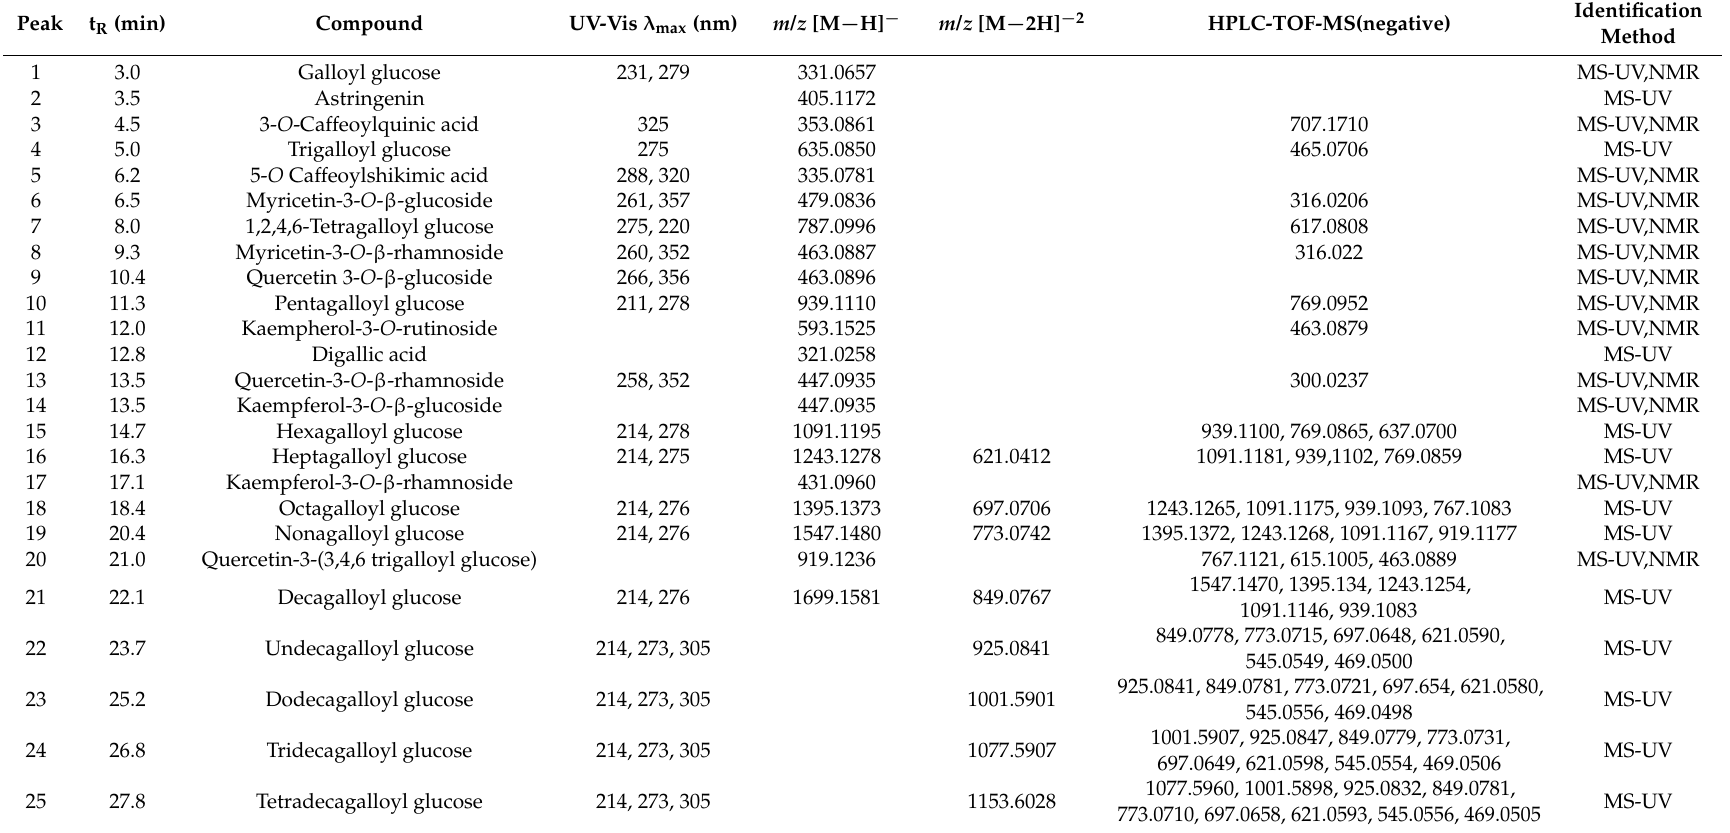
Table 1. List of compounds isolated and/or detected in the EtOAc extract of P. persica